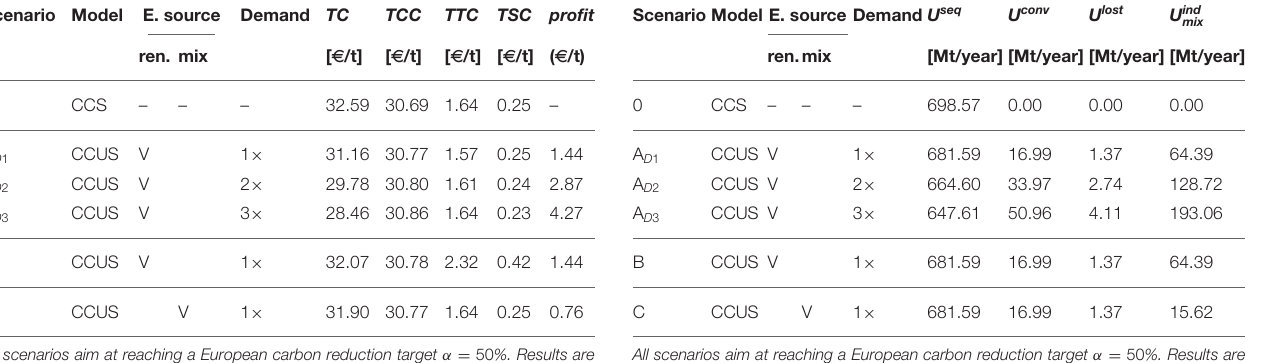
TABLE 4 | Main assumptions and results for Scenario 0, Scenario A, Scenario B, and Scenario C. Scenario Model E. source Demand TC